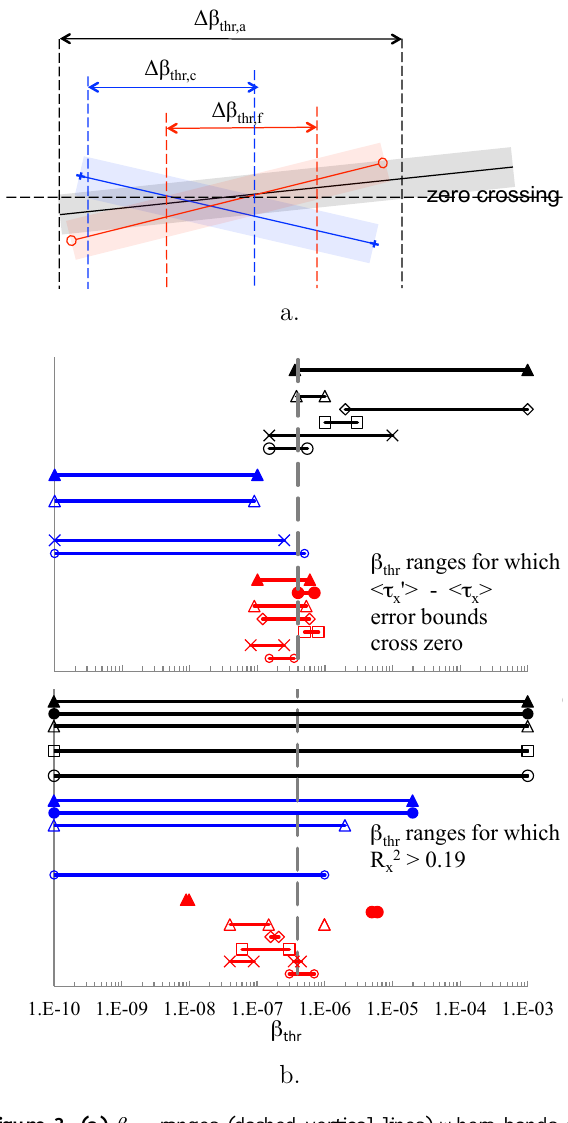
> < τ > , < τ 0 > < Figure 1: a) β ranges (dashed vertical lines) where bands of < τ 0 Figure 3. (a) β thr ranges (dashed vertical lines) where bands of thr f f c − − (cid:104) τ (cid:48) (cid:105)−(cid:104) τ (cid:105) , (cid:104) τ (cid:48) (cid:105)−(cid:104) τ c (cid:105) and (cid:104) τ (cid:48) (cid:105)−(cid:104) τ a (cid:105) cross the zero line (horizon- τ > and < τ 0 > < τ > cross the zero line (horizontal dashed line) for an optical depth f c a c a a f − tal dashed line) for an optical depth error represented by the semi- error represented by the semi-transparent bands of red, blue and grey respectively. The transparent bands of red, blue and grey respectively. The diagram diagram is meant to be a conceptual representation of the analogous real data shown in the is meant to be a conceptual representation of the how error bar middle graph of Figure 2b. b) Top: derived β ranges, for an assumed optical depth error of thr banding would be applied to real data such as the middle graph > 0 . 19. The end symbols of each horizontal segment 0.03. Bottom: β ranges for which R 2 thr x of Fig. 2a. (b) Derived β thr ranges for all events (with red, blue : o, X, X, X, X, X and X represent respectively, the event dates of Mar 9, 10 and Feb. 21 of and black representing, as always, the fine, coarse and total com- 2011 and Mar. 13, 14, 15 as well as the combination of Mar. 1315, 2012. The grey, dashed ponents). The top graph shows ranges for an assumed optical depth vertical line indicates, unless otherwise stated, the nominal value of β = 4 10 − 7 m 1 sr 1 error of 0.03 ( (cid:49)β thr as per a ), while the bottom graph shows ranges thr × for R 2 x > 0 . 19. The end symbols of each horizontal segment: ◦ , X, chosen for the event analyses of Section 5. (cid:3) , (cid:5) , (cid:52) , • and (cid:78) represent, respectively, the event dates of 9 and 10 March and 21 February 2011 and 13, 14, 15 March as well as the combination of 13–15 March 2012. The grey, dashed vertical line indicates, the nominal value of β thr = 4 × 10 − 7 m − 1 sr − 1 cho- sen for the event analyses of Sect.